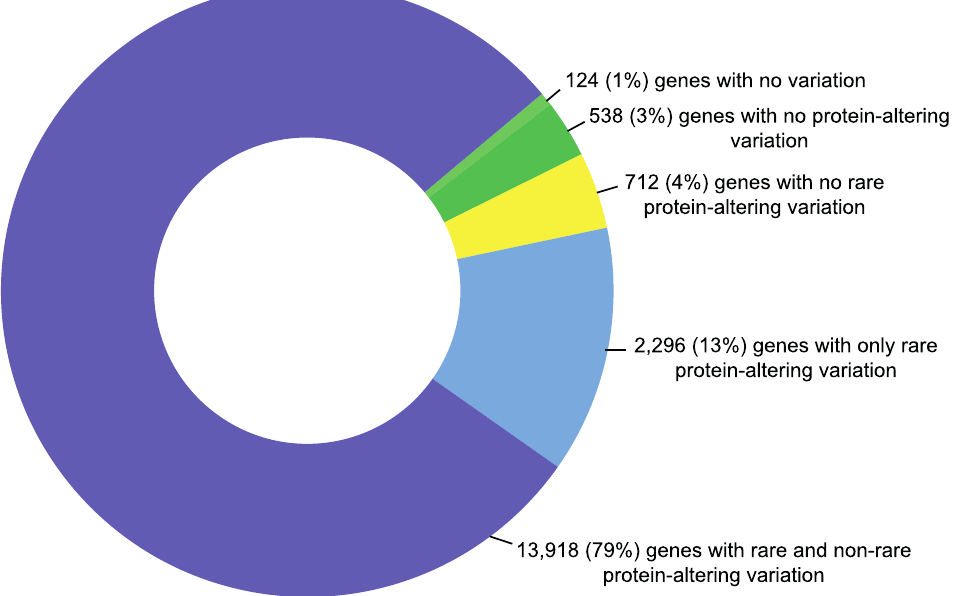
Figure 2. Summary of gene variation in the ICR1000 UK exome series. Protein-altering variation includes nonsynonymous variants, inframe indels and protein-truncating variants (i.e. frameshifting indels or variants that alter essential splice-site residues). The majority of genes include variants across the frequency